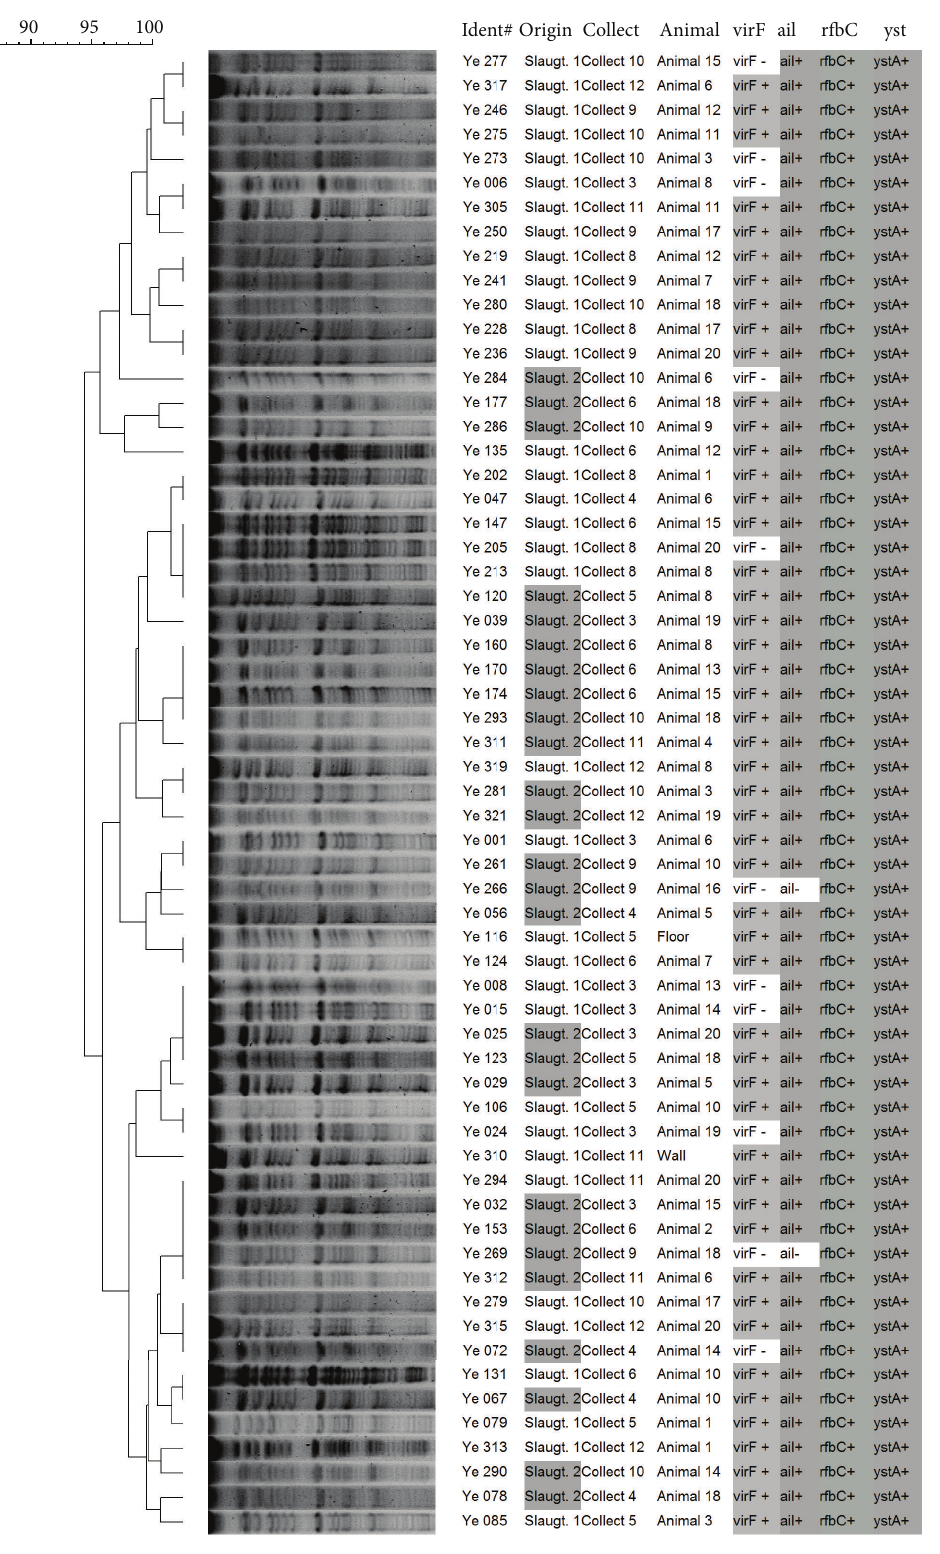
Figure 3: Dendrogram showing comparison of Y. enterocolitica biotype 4/O:3 isolates by